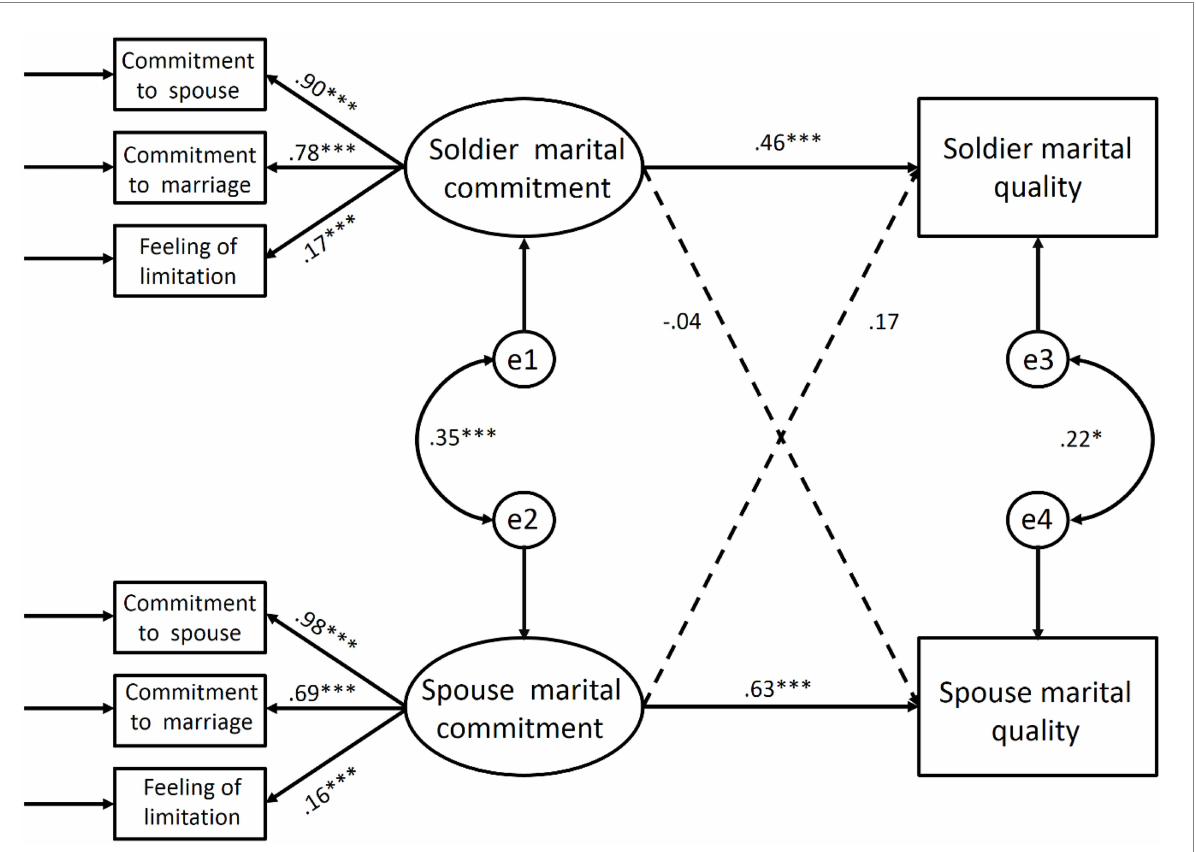
FIGURE 2 The path relationship between soldier and spouse marital commitment and their respective marital quality. * p < 0.05; *** p <